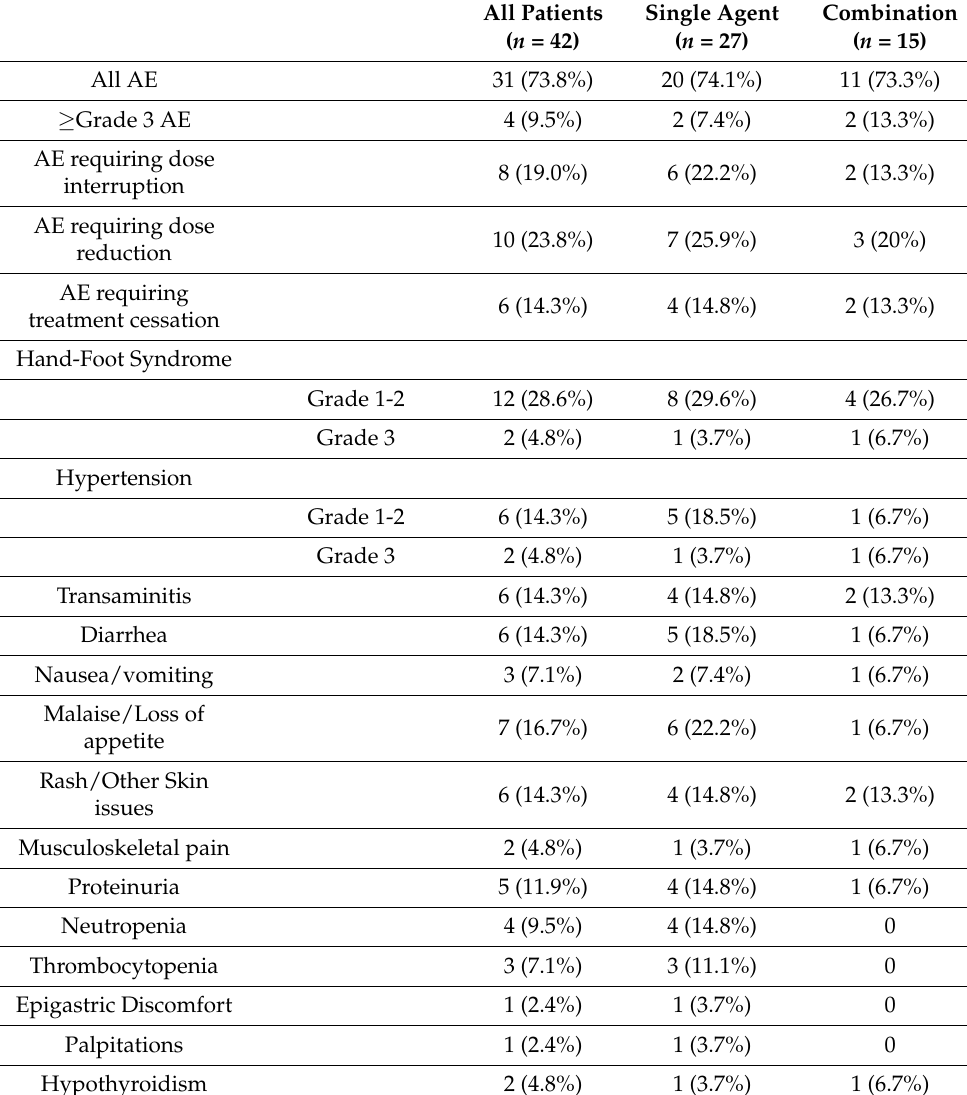
Table 3. Adverse events